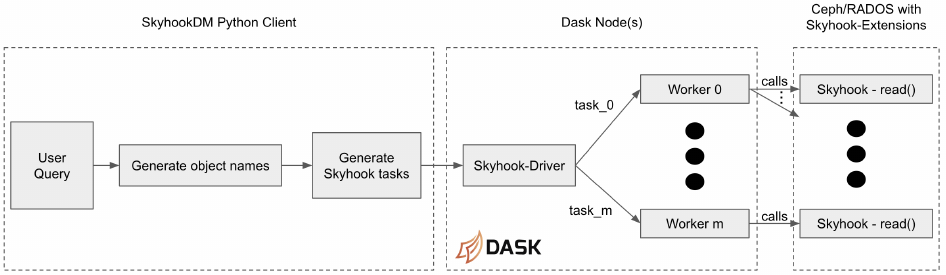
Figure 4. SkyhookDM Workflow: Execute User